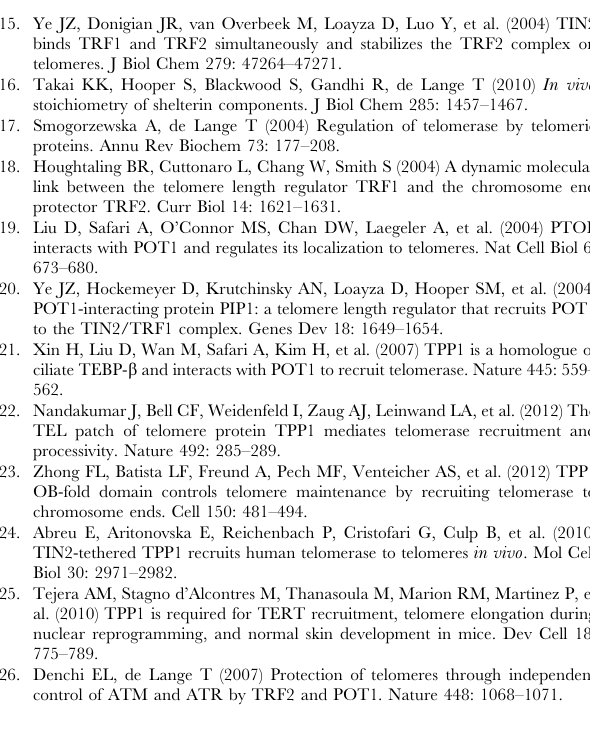
Figure S11 Binding of the Tpz1-Pot1 complex to telomere oligo primer does not depend on Tpz1-Ccq1 or Tpz1-Poz1 interaction. ( A ) A schematic overview for the telomere oligonucleotide primer pull-down assay. Biotin-conjugated primers were bound to streptavidin-conjugated magnetic beads, and incubated with whole cell extracts from cells to monitor Pot1-dependent binding to Tpz1. ( B ) Tpz1 specifically associated with the telomeric G- oligo but not the complementary telomeric C-oligo. The interaction of Tpz1 with G-oligo was lost in pot1 D cells. (See Materials and Methods.) ( C ) Tpz1-Pot1 interaction was not affected by Tpz1-Ccq1 or Tpz1-Poz1 interaction disruption mutants. ( D ) Tpz1-Pot1 interaction remained intact even in ccq1 D poz1 D cells. Interaction between Tpz1-myc and Pot1-FLAG was monitored by co-IP of Pot1-FLAG after anti-myc pull down of Tpz1-myc. For whole cell extract (WCE) western blot, Cdc2 served as a loading control. Figure S12 Characterization of Tpz1-Poz1 interaction disrup- tion mutant cells. Telomere length analysis by Southern blot was performed for strains used in ( A ) Tpz1, ( B ) Ccq1, ( C ) Poz1, and ( D ) Trt1 TERT ChIP assays (Figures 7A–D and S13). Figure S13 Raw data for Tpz1, Ccq1, Poz1 and Trt1 TERT ChIP assays in Tpz1-Poz1 interaction mutant cells. Effects of disrupting Tpz1-Poz1 interaction on telomere association for ( A ) Tpz1, ( B ) Ccq1, ( C ) Poz1 and ( D ) Trt1 TERT were monitored by dot-blot ChIP assays and raw % precipitated DNA values were plotted. These data were then corrected for telomere length [36] to generate plots shown in Figure 7. Error bars represent standard